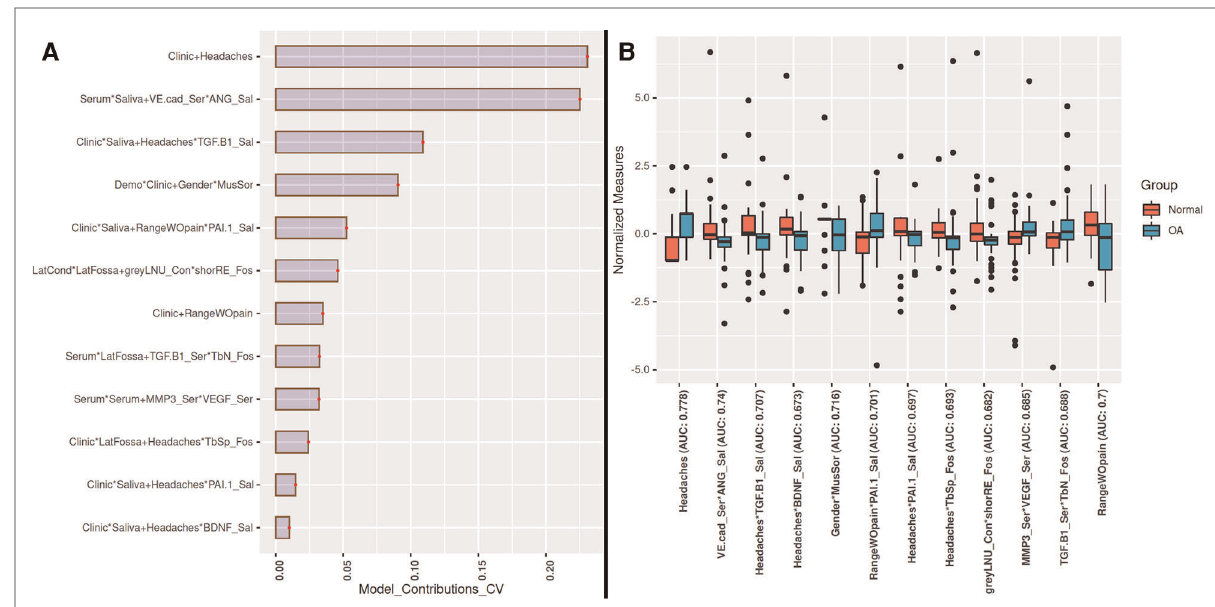
FIGURE 6 Top 12 features in the LightGBM prediction model. ( A ) Mean contribution (according to feature importance) greater than 90% for 100 times 5-fold CV. ( B ) Boxplots of normalized features to diagnose disease